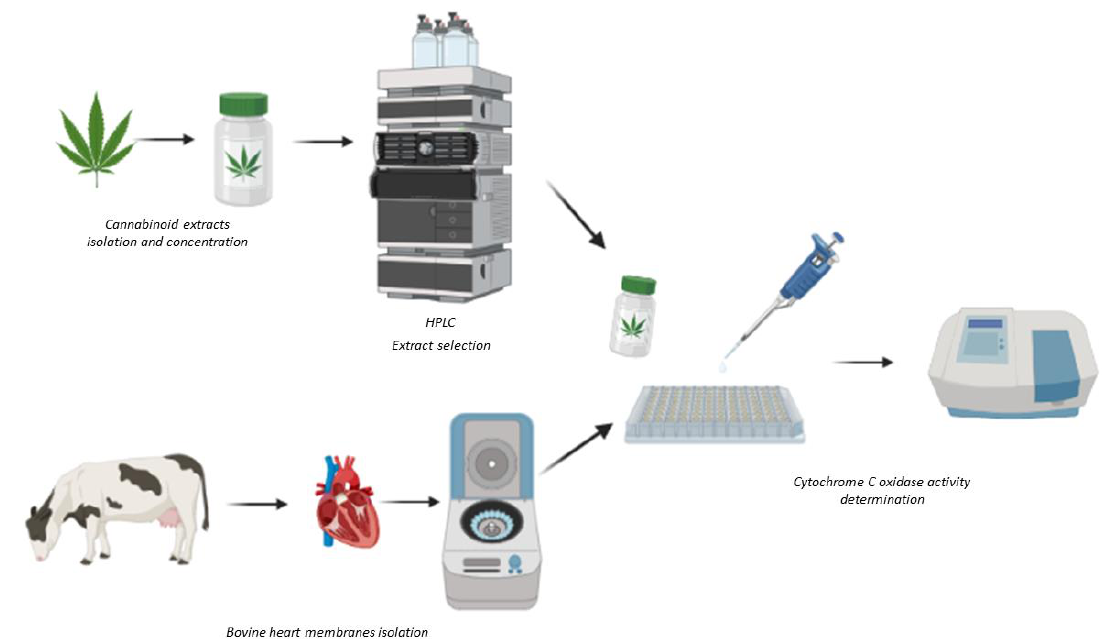
Figure 1. Scheme of the methodology used for sample preparation and the determination of cy- tochrome c oxidase activity. Created with BioRender.com.